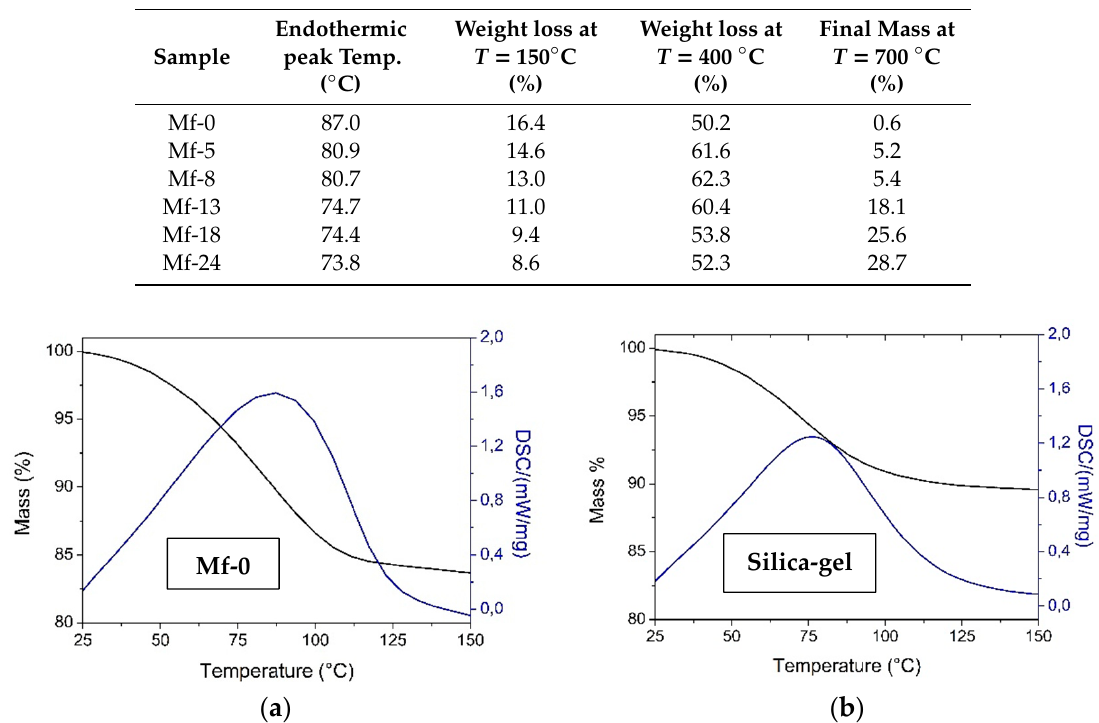
Figure 5. TGA-DSC comparison between pure PVP microfibres ( a ) and silica gel ( b ) ( T = 25–150 °C).